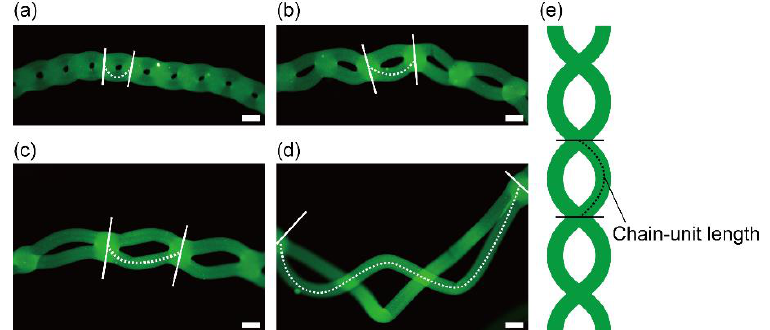
Figure 7. Fluorescent images of chained alginate microfibers with different chain-unit lengths. Microfibers were formed at flow rates of ( a ) 7.0 mL/min; ( b ) 7.5 mL/min; ( c ) 8.0 mL/min; and ( d ) 8.5 mL/min. The dotted line between two lines represents the chain-unit length; ( e ) Conceptual image of chain-unit lengths. Scale bars are 500 µm.